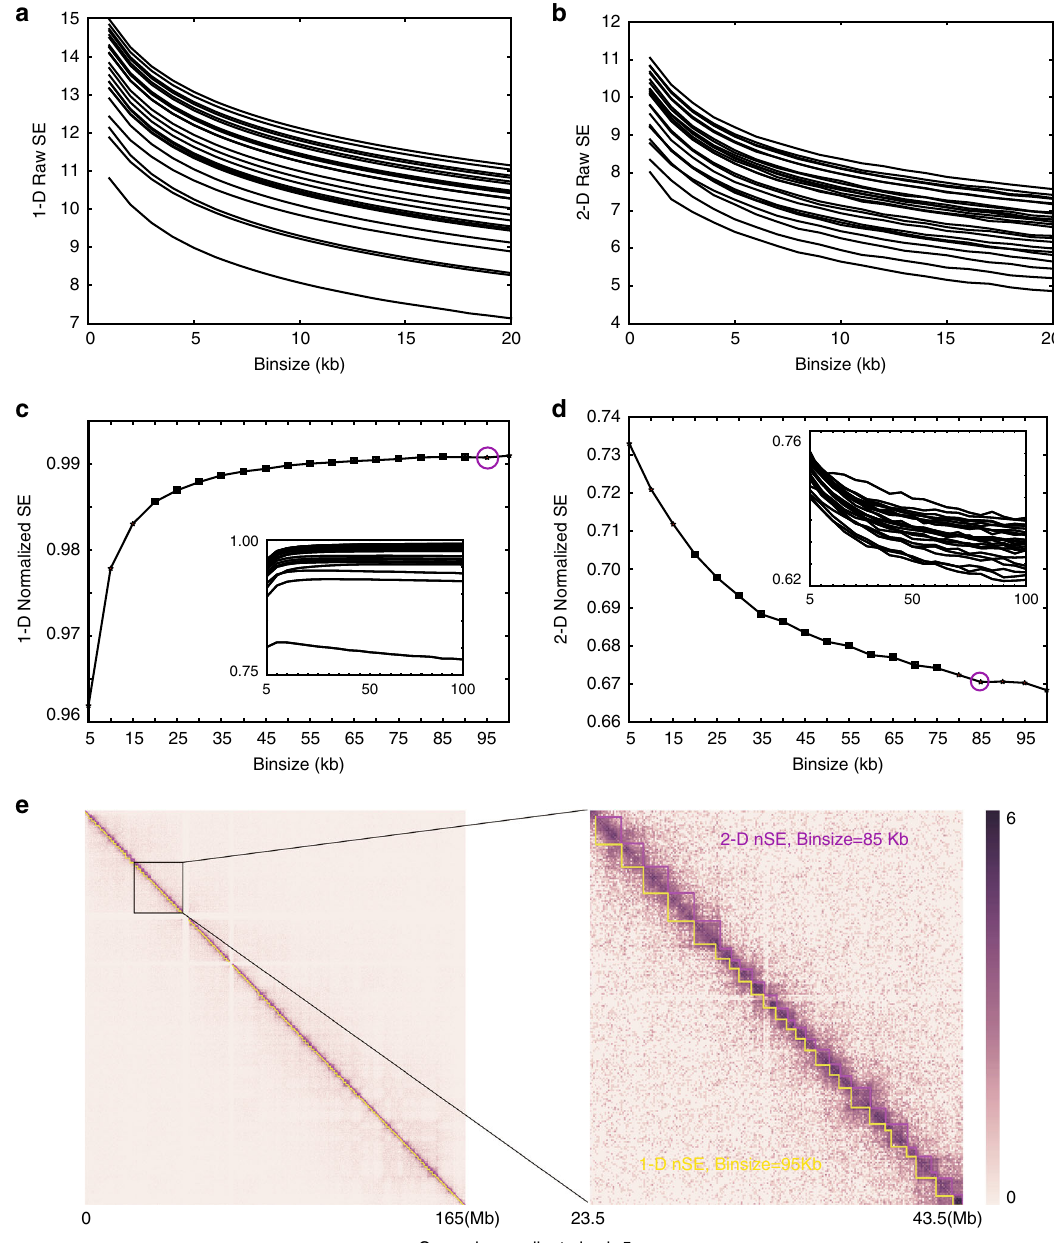
Fig. 4 Using SE to determine the proper binsize for a given Hi-C dataset. Before normalization both a 1D-SE and b 2D-SE decrease in a near-monotonic manner with increasing binsizes in all 24 chromosomes. After normalization, both c 1D-SE and d 2D-SE differ far less with binsize for most of the binsize range. The main plots show data from chromosome 5, and the minimum stable binsizes are marked as magenta circles. The embedded plots show the curves for all 24 chromosomes. e Heatmap of the Hi-C data for chromosome 5 in hES cells taken from the data of Dixon et al. 6 deDoc(M) predicted domains using binsizes of 85 and 95 kb are highlighted in magenta and yellow sawteeth, respectively. The two binsizes were determined by 1D-SE and 2D- SE, respectively, as the best